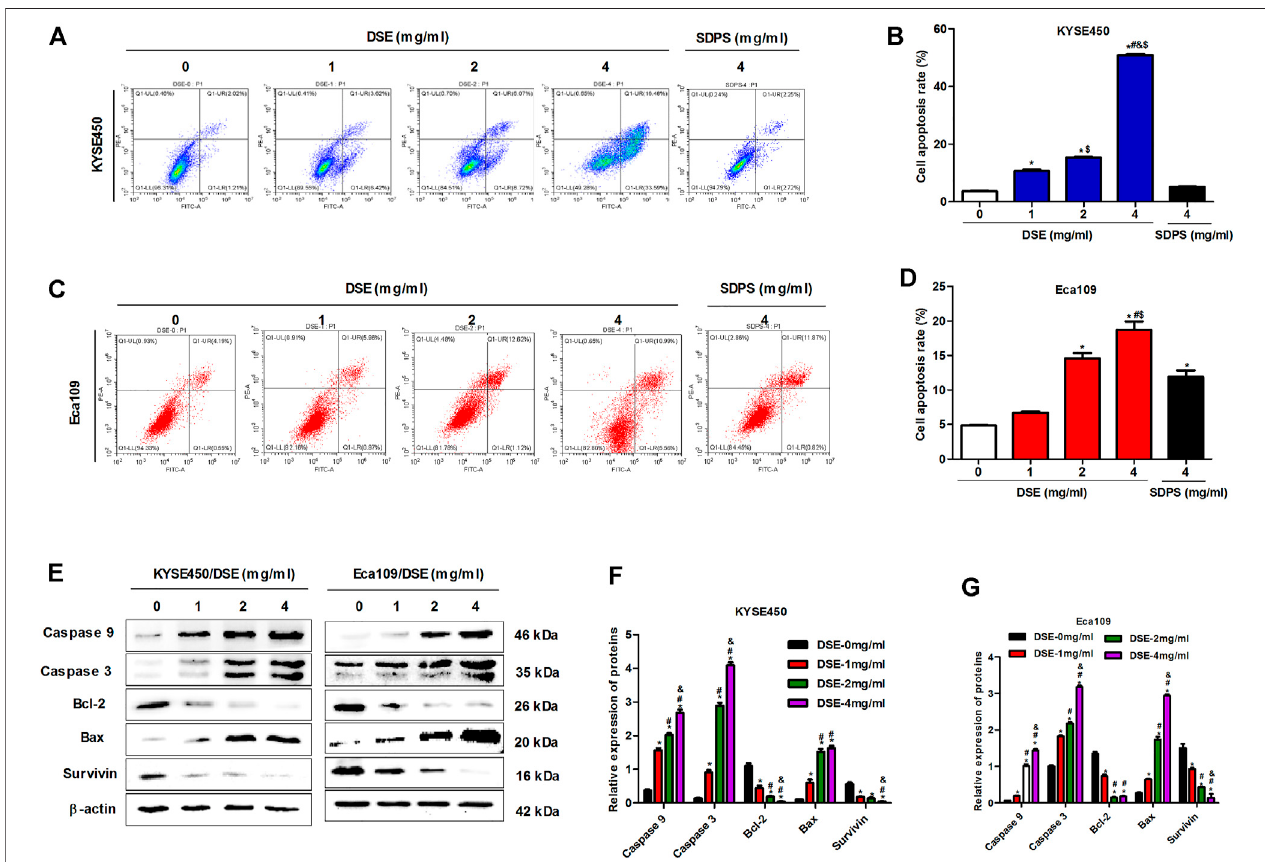
FIGURE3| DSEinducescellapoptosisandregulatestheexpressionofsuivivin,Bcl-2,Bax,caspase3/9proteinsinhumanESCCcells. (A – D) EffectsofDSEoncell apoptosis in KYSE450 and Eca109 cells. All data are expressed as mean ± standard deviation ( n = 3). * p < 0.05 vs. 0 mg/ml DSE group. # p < 0.05 vs. 1 mg/ml DSE group. & p < 0.05 vs. 2 mg/ml group. $ p < 0.05 vs. positive control SDPS group. (E – G) Effects of DSE on the expression of suivivin, Bcl-2, Bax, caspase3 and caspase9 proteins in KYSE450 and Eca109 cells. All data are expressed as mean ± standard deviation ( n = 3). * p < 0.05 vs. 0 mg/ml DSE group. # p < 0.05 vs. 1 mg/ml DSE group. & p < 0.05 vs. 2 mg/ml